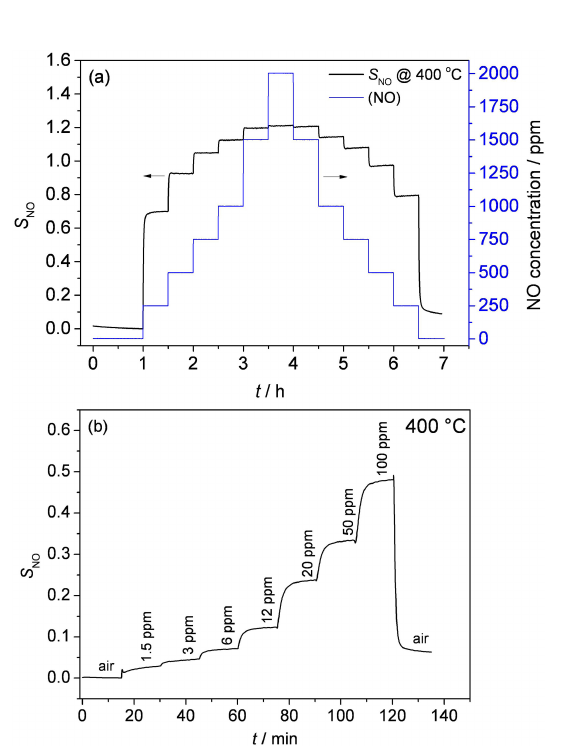
Figure 7. Response of an ADM BFT30 sensor at 400 ◦ C. (a) NO concentrations from 250 to 2000ppm, (b) NO concentrations be- tween 1.5 and